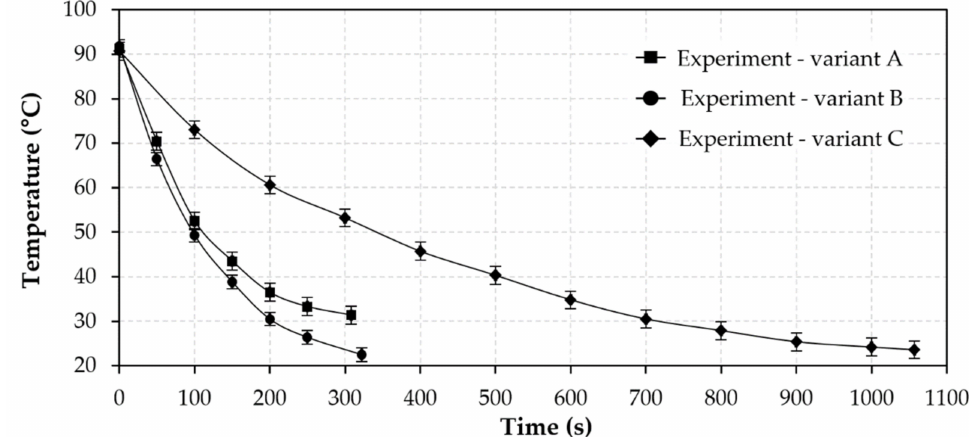
Figure 11. Cooling curves for experiment variants